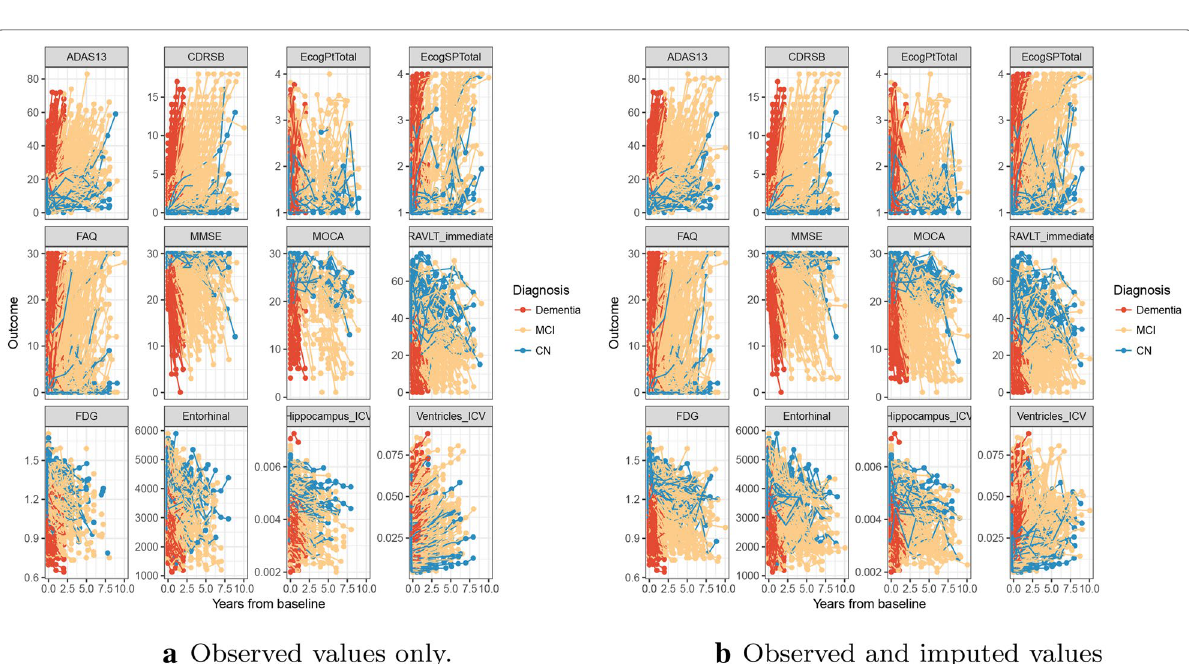
Fig. 8 Observed and imputed values. The MissForest algorithm was used to impute missing values which appear to be plausible when compared to observed values at other visits. CN Control, MCI mild cognitive